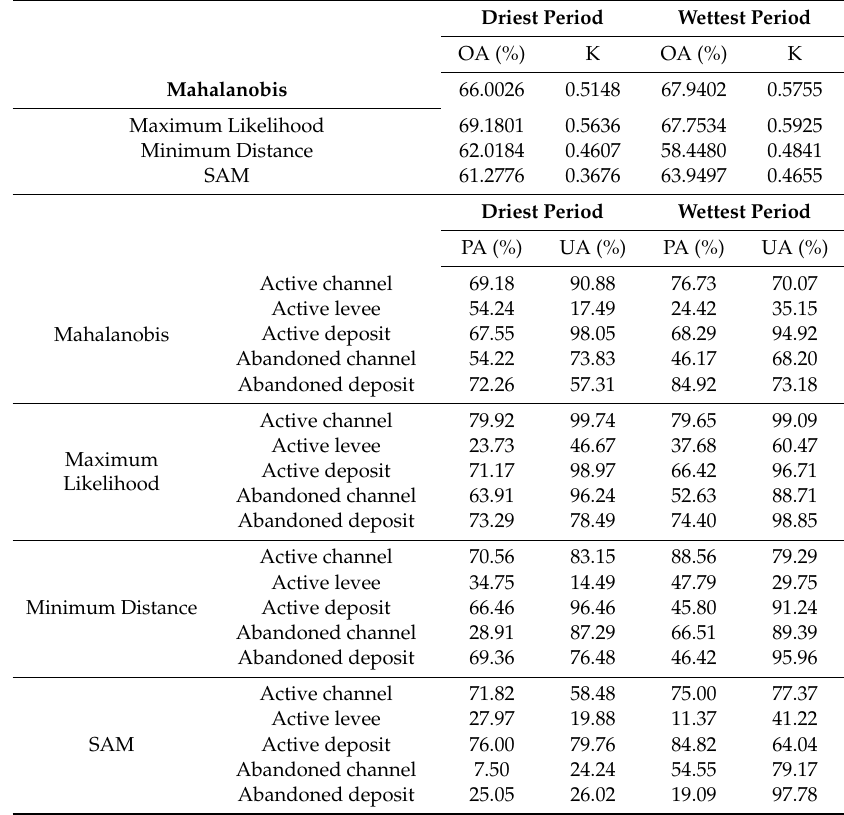
Table 2. Accuracy of each ROIs derived from the di ff erent classification methods applied in this